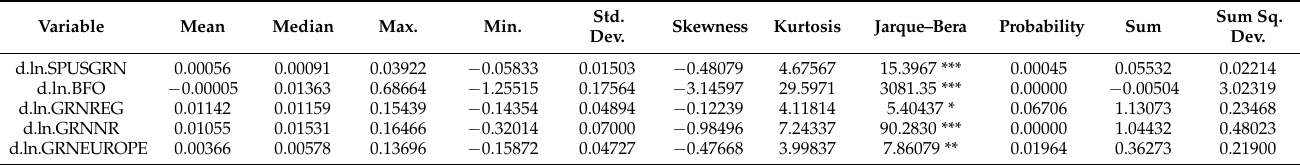
Table 2. Descriptive statistics of the time series of log returns of the analyzed